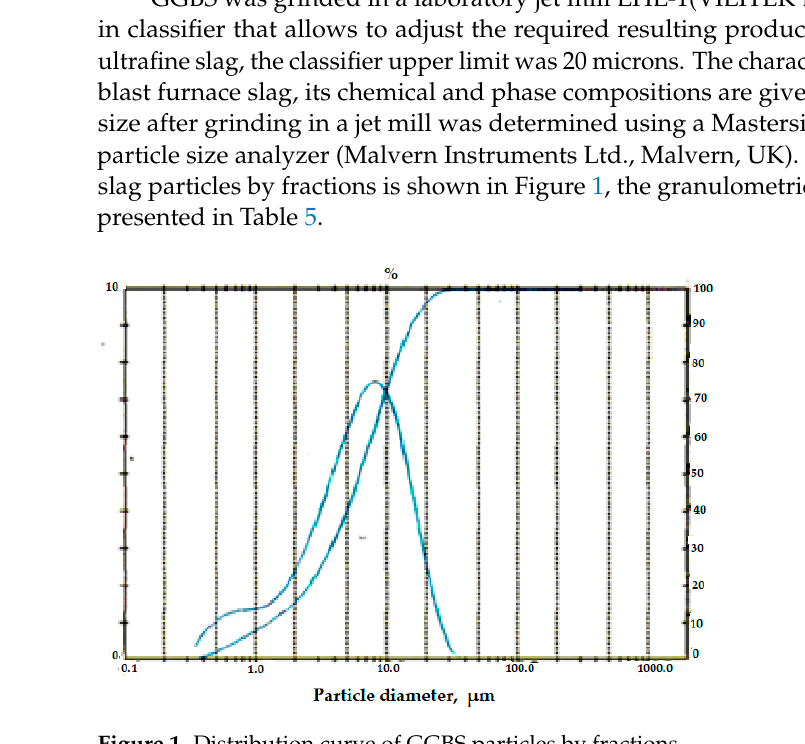
Figure 1. Distribution curve of GGBS particles by fractions. Table 5. Granulometris composition of GGBS.